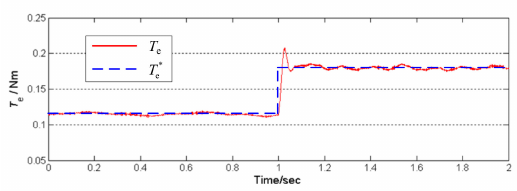
Figure 23. Electromagnetic torque of i d = 0 control.